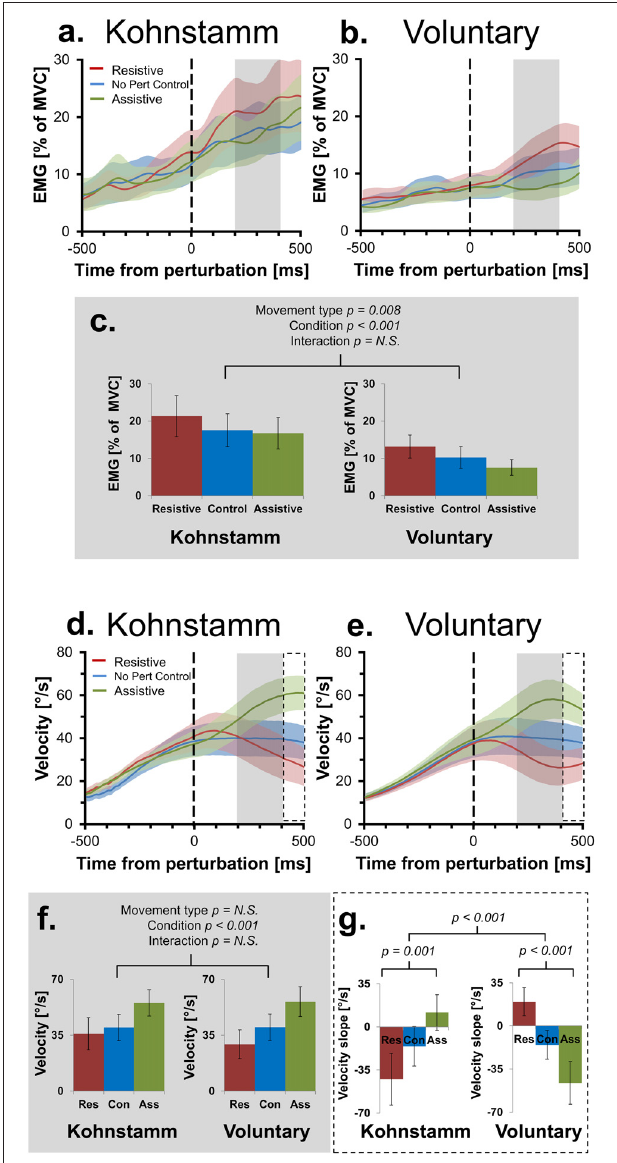
FIGURE 3 | Mean smoothed agonist EMG and velocity of movement across movement types and perturbation conditions. Agonist smoothed group EMG (% MVC) across conditions, from 500 ms prior to onset of perturbation to 500 ms post-perturbation, for Kohnstamm (A) and Voluntary movements (B) . Mean EMG 200–400 ms post-perturbation (C) . There was significantly higher EMG during Kohnstamm movements than Voluntary movements during this time window. EMG increased in the Resistive perturbation condition and decreased in the Assistive perturbation condition, relative to the